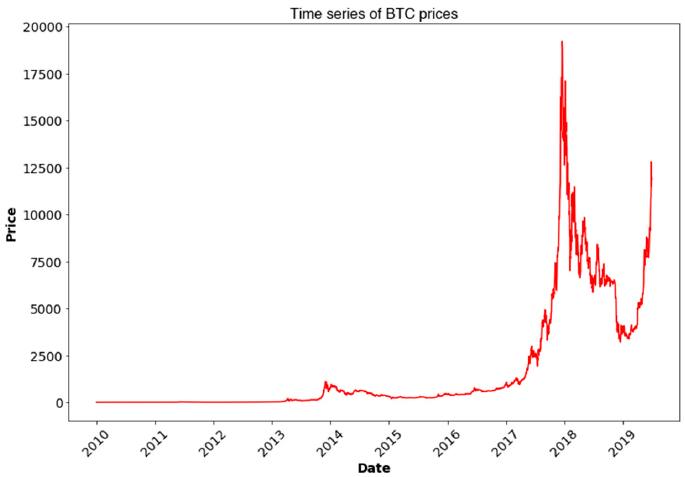
Figure 3. Time series plot of Bitcoin price in USD.